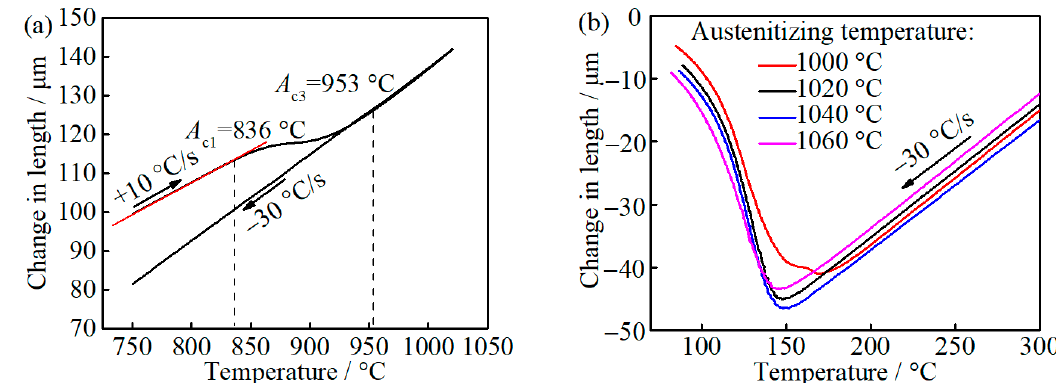
Figure 2. The relative length change of dilatometric samples with temperature: ( a ) heating and cooling; and ( b ) cooling from different austenitizing temperature.